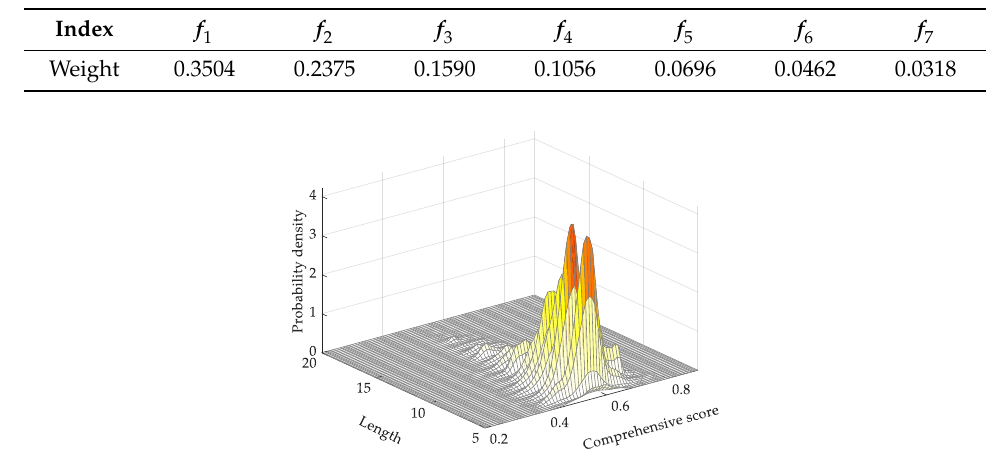
Table 4. Single ranking weights of the index layers.